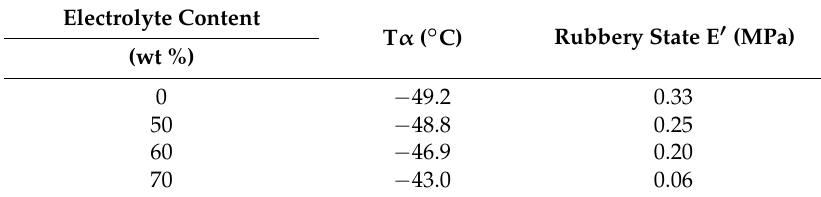
Table 7. DMA data of PPO-Jeffamine/Electrolyte networks.